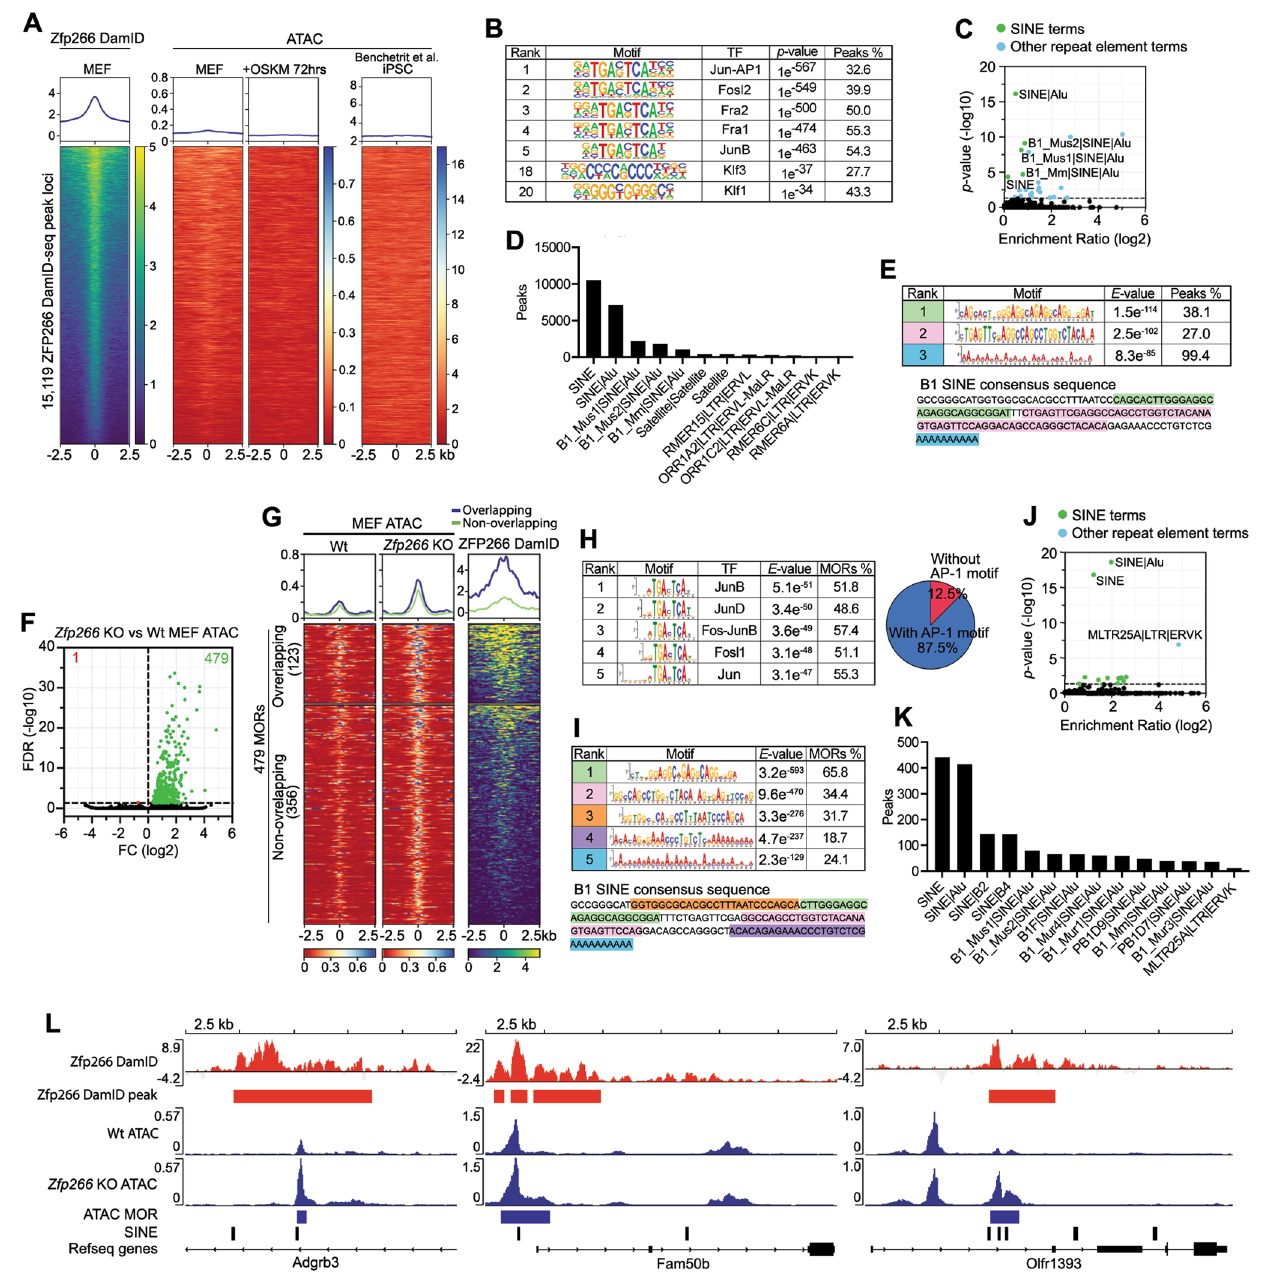
Fig.4| Zfp266 KOinMEFsresultsinchromatinopeningattheSINE-containing ZFP266bindingsites.A ZFP266 DamID-seq signals in MEFs, ATAC-seq signals in MEFs, +72h of reprogramming, and iPSCs at the ZFP266 DamID-seq peak loci. B Motif enrichment analysis with HOMER on ZFP266 DamID-seq peaks. C Signi fi cance and fold enrichment ratio of transposable element (TE) families overlap with Dam-ZFP266 peaks. Green dots indicate signi fi cantly enriched SINEs, blue dots indicate other signi fi cantly enriched TEs. The p -values were calculated by the cumulative hypergeometric distribution (a one-tailed test) in B and C . D NumberofZFP266DamID-seqpeaksthatoverlapwithTEs. E Denovo motifdiscoveryanalysiswith MEMEon ZFP266DamID-seqpeaks.Theidenti fi ed motifs correspond to parts of the B1 SINE consensus sequence, indicated by matching colors. F Volcano plot of Zfp266 KO vs Wt MEF ATAC-seq. Green and red dots indicate more open regions (MORs) and more closed regions in Zfp266